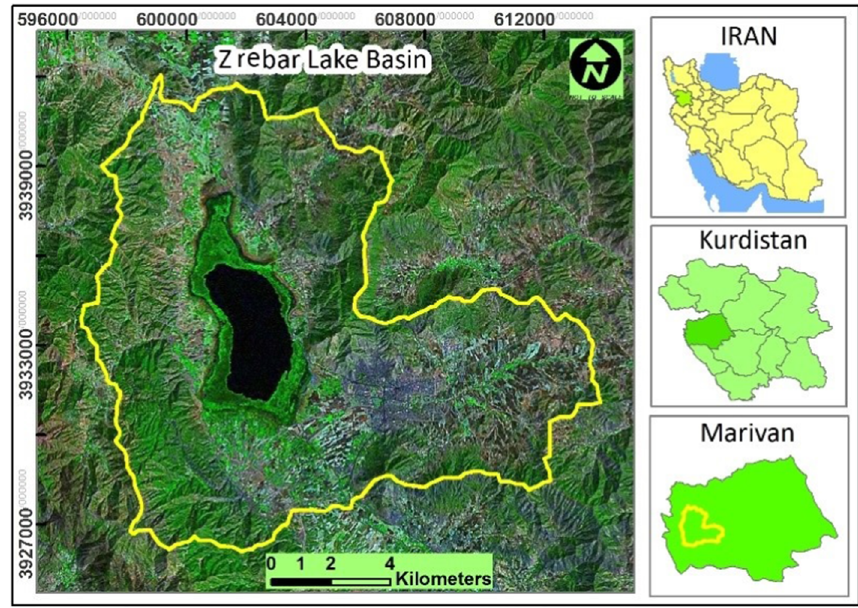
Fig. 1 The map of the location